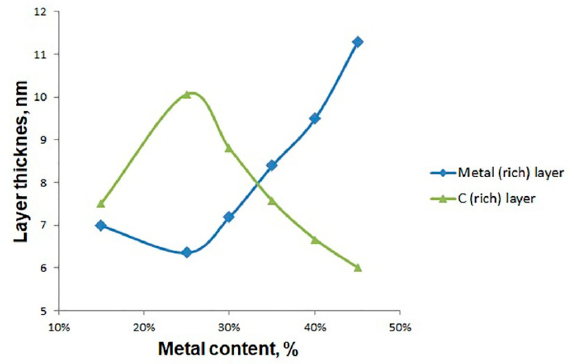
Figure 6. Dependencies of layer thickness on the metal content in layered thin films.